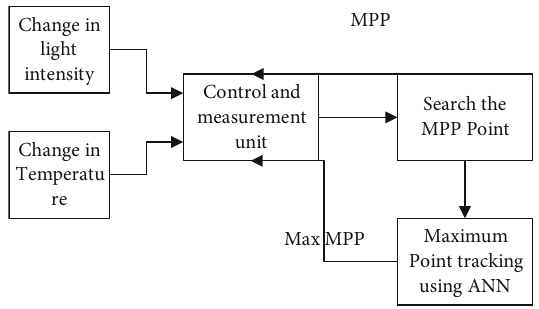
Figure 1: Schematic diagram of the proposed ANN